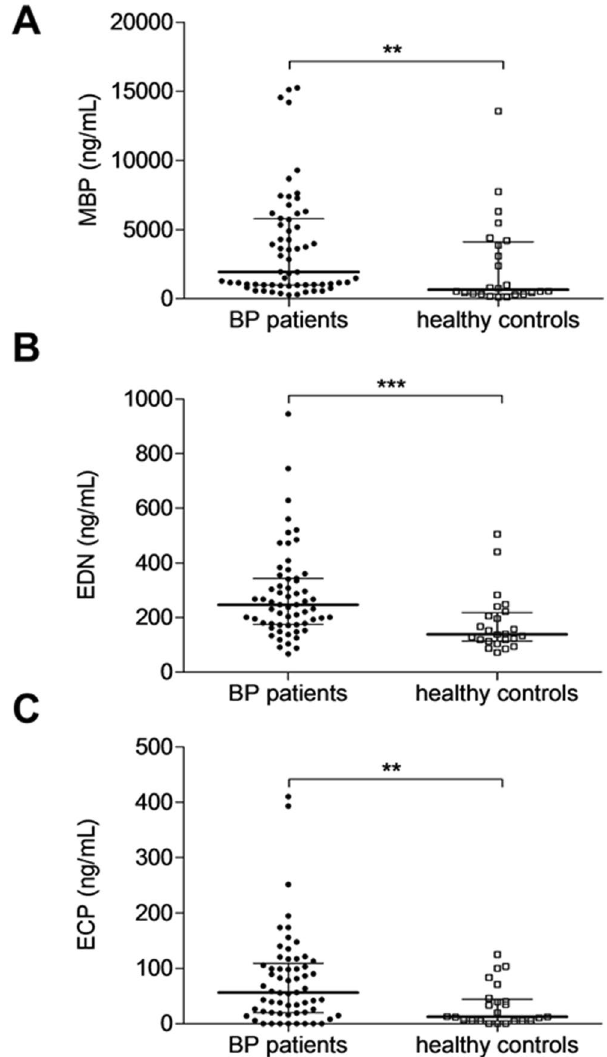
Figure 1. Serum concentrations of Eosinophil granule proteins at baseline. Major Basic Protein (MBP) ( A ), Eosinophil Derived Neurotoxin (EDN) ( B ) and Eosinophil Cationic Protein (ECP) ( C ) serum levels from 61 patients with active bullous pemphigoid and 24 healthy control subjects were measured by specific ELISA at the time of diagnosis. Results are expressed as ng/mL. ( ** P < 0.01; *** P < 0.001 ). Lines correspond to median and interquartile